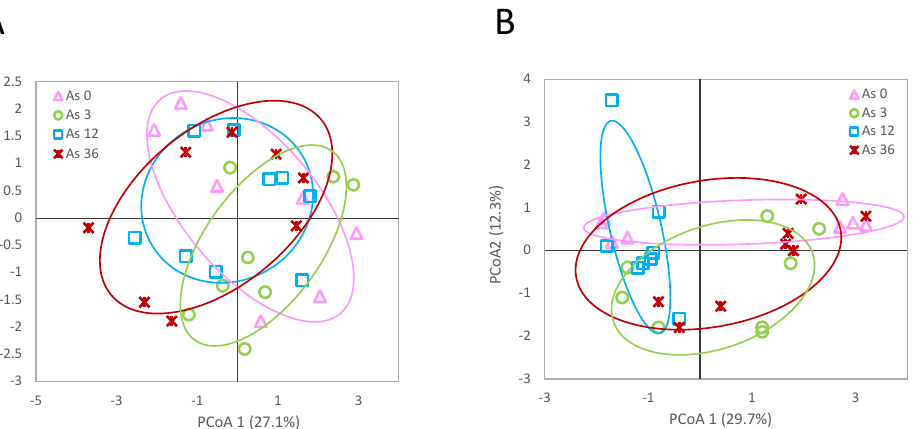
Figure 1. Principal Coordinate Analysis of the detected methylation ( A ) and genetic polymorphism ( B ) site patterns at the sequence 5 ′ -CCGG-3 ′ for L. rubellus exposed for 280 days to a control and 3, 12 and 36 mg/kg per dry weight soil As throughout development from early juvenile stage.